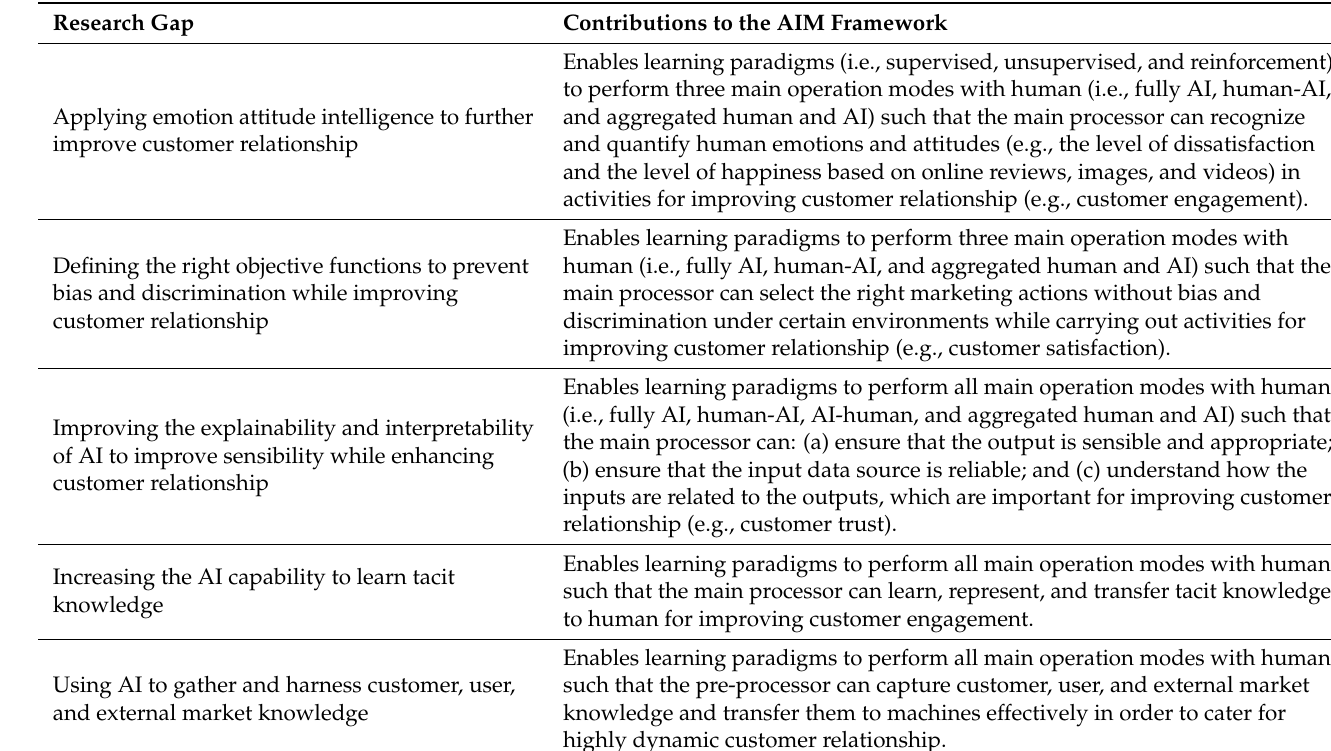
Table 5. Research gaps and their contributions to the AIM